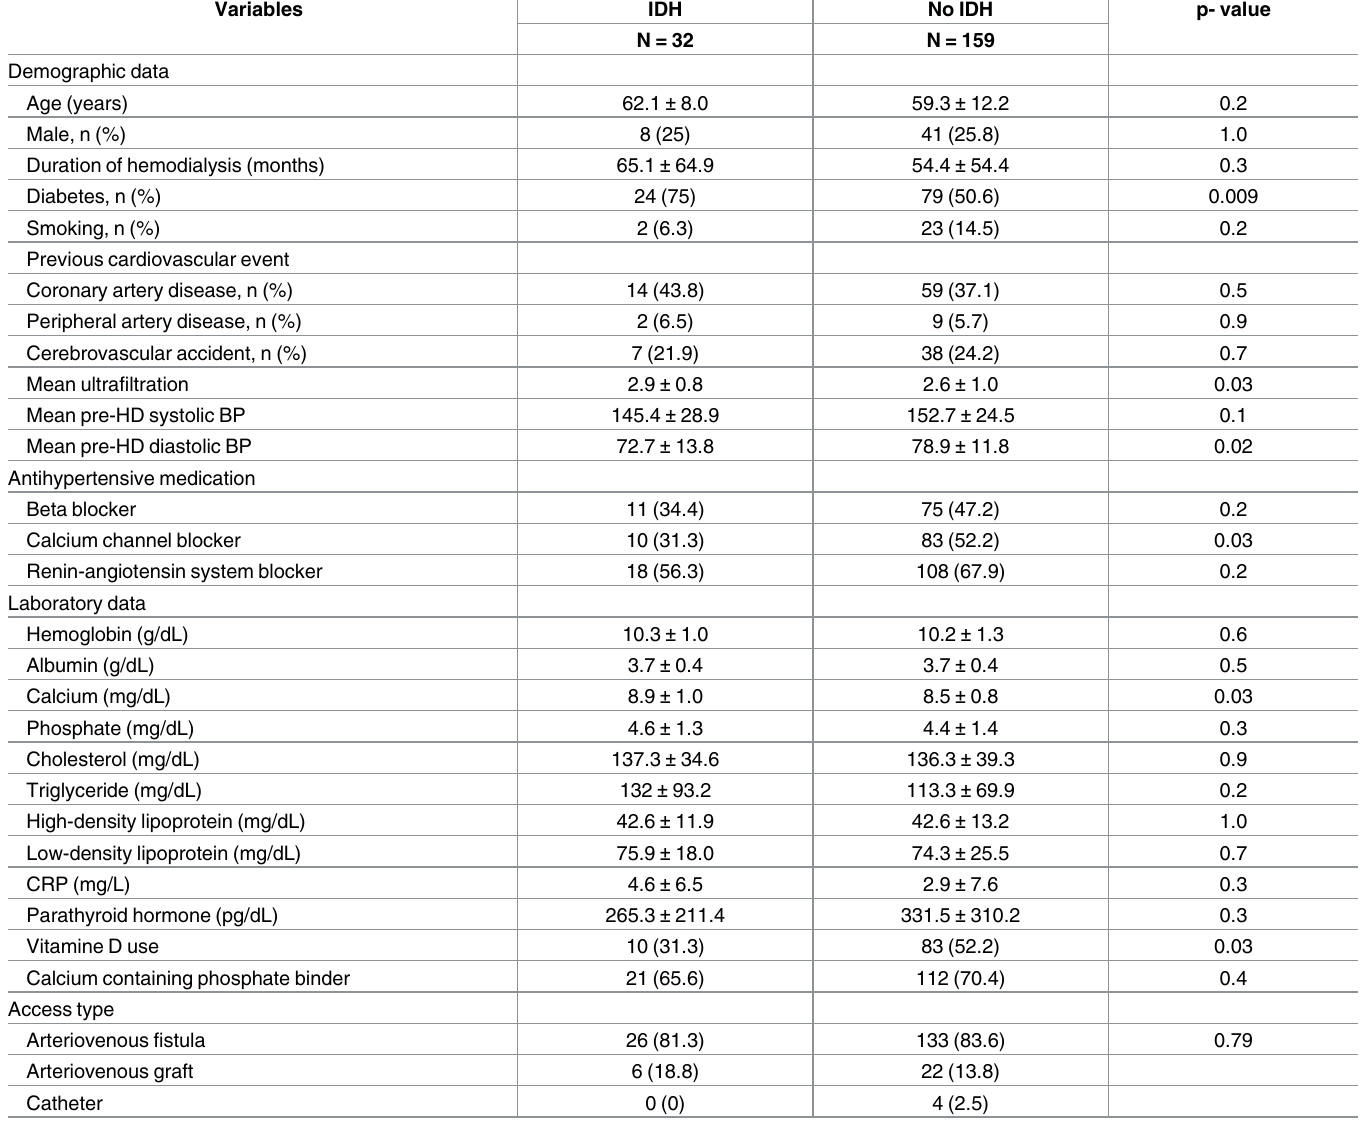
Table 1. Baseline demographics and biochemical variables in study population according to